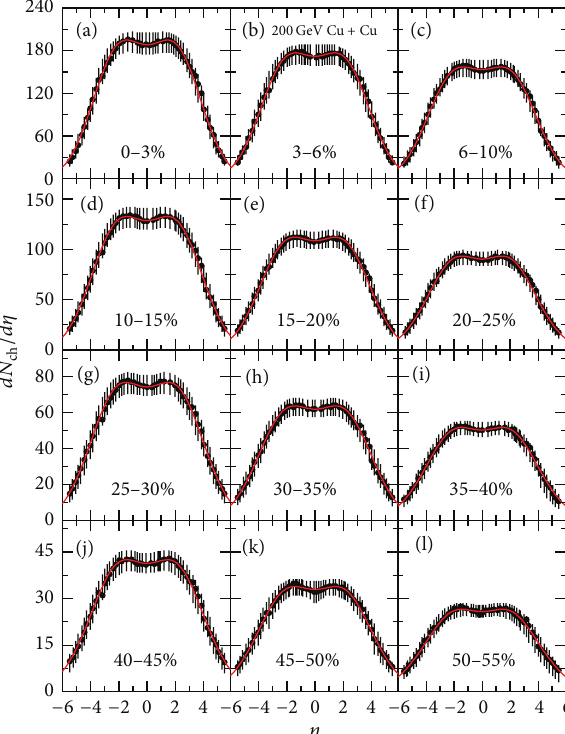
/𝑑𝜂 versus 𝜂 for different centrality bins in Pb-Pb Figure 8: 𝑑𝑁 ch collisions at √𝑠 𝑁𝑁 = 2.76 TeV. The circles and curves represent the experimental data of the ALICE collaboration [21] and our calculated results,